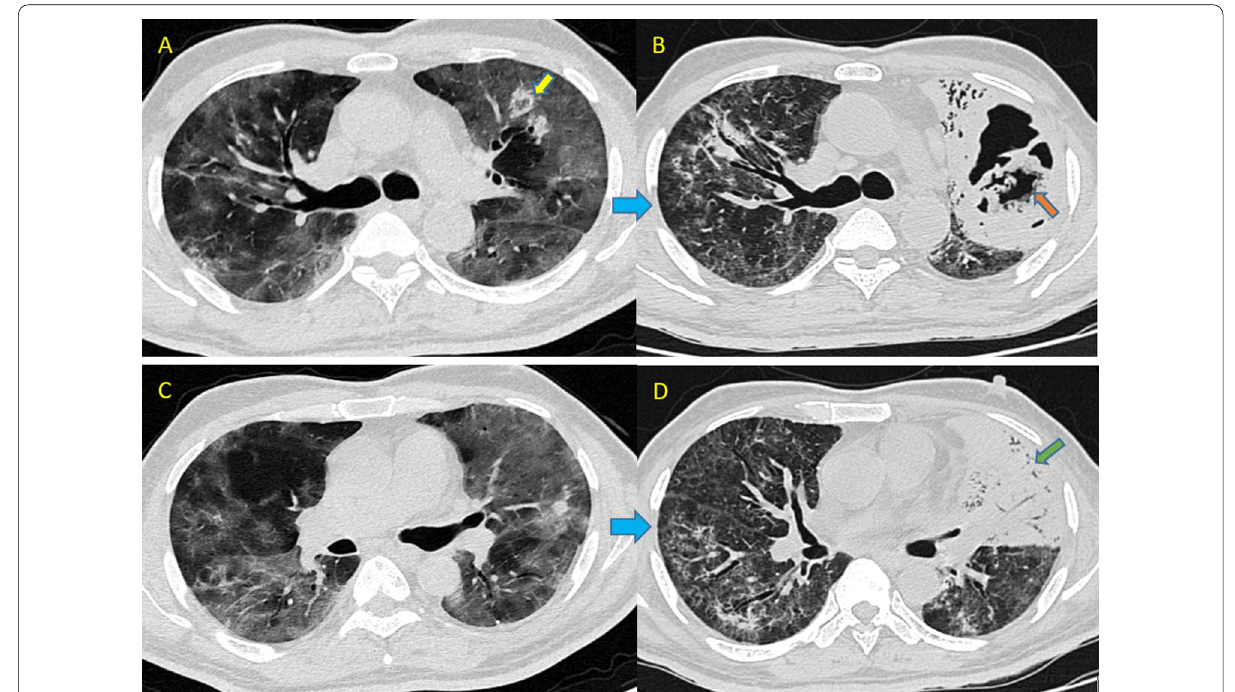
Fig. 1 Imaging features of mucormycosis in Case 1 of COVID-19. A , B Axial HRCT scans show diffuse ground glass opacities in bilateral lung fields with few patches of reverse halo lesions (yellow arrow in A ), without any evidence of cavitation. The scan was repeated after 21 days revealed cavitary lesions with soft tissue attenuating irregularly margined growth suggesting fungal infestation (orange arrow in B ). C , D Revealed rapid progression of GGOs into consolidation (Green arrow in D